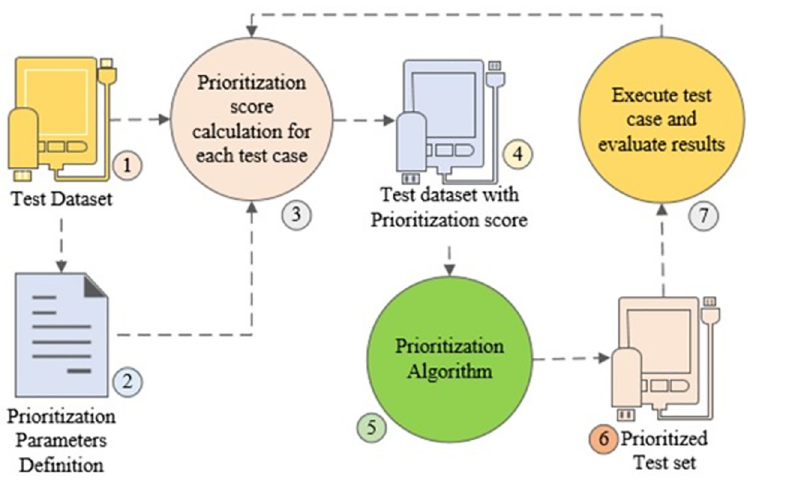
Fig 6. Test case prioritization